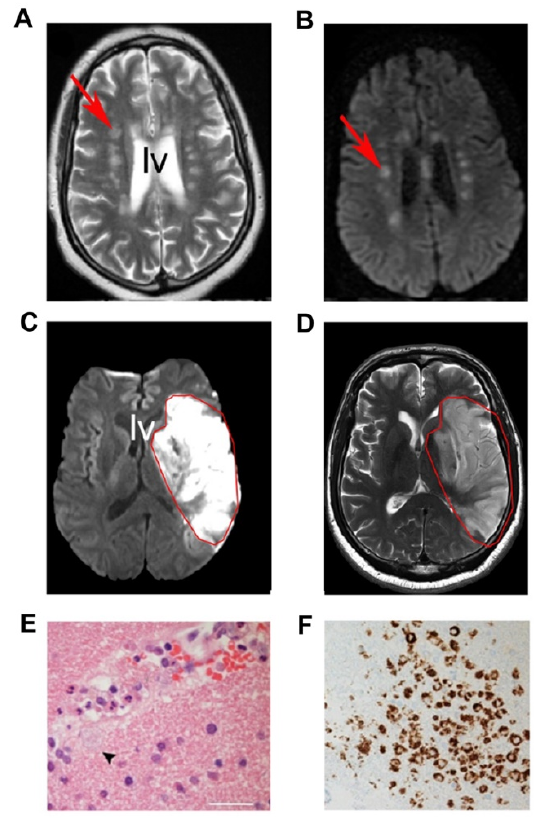
Figure 4. CNS pathology in COVID-19 victims. ( A , B ) MRI showing small foci of injuries (arrows) near the lateral ventricle (LV) and SVZ. ( C , D ) Large lesion (outlined in red) near the lateral ventricles. ( E ) A small blood vessel surrounded by immune cells that invaded the brain. Note macrophage extending into brain (small arrowhead). ( F ) CD68 immunohistochemistry showing macrophages around small vessels. (Adapted from Paterson et al., 2020), with permission.